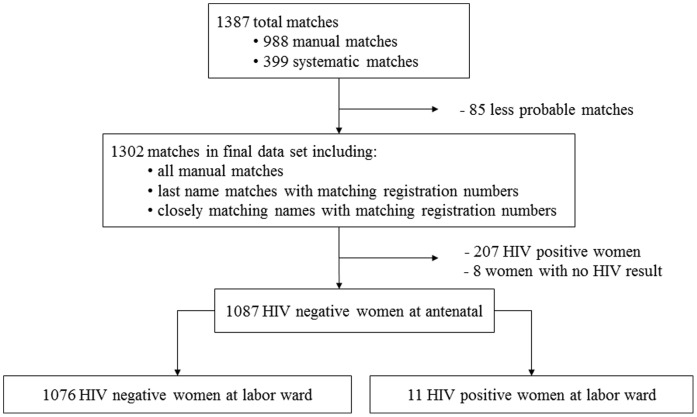
Matching schematic for HIV incidence calculation in the antenatal population at Bwaila Hospital.Antenatal and labor ward records were matched manually and systematically resulting in 1302 final matches whose antenatal and labor ward HIV test results were compared. Of 1087 HIV negative women at the initial antenatal test, 11 tested HIV positive at the labor ward indicating a seroconversion risk of 1% during pregnancy.